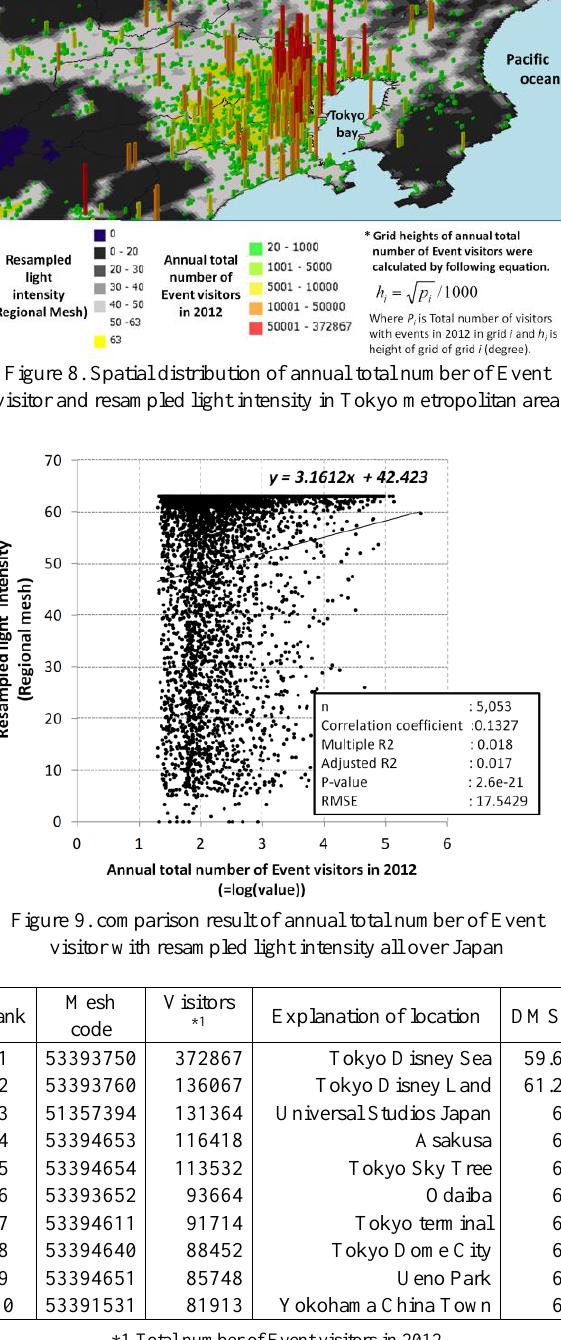
Table 1. Top 10 Regional Mesh of annual total number of